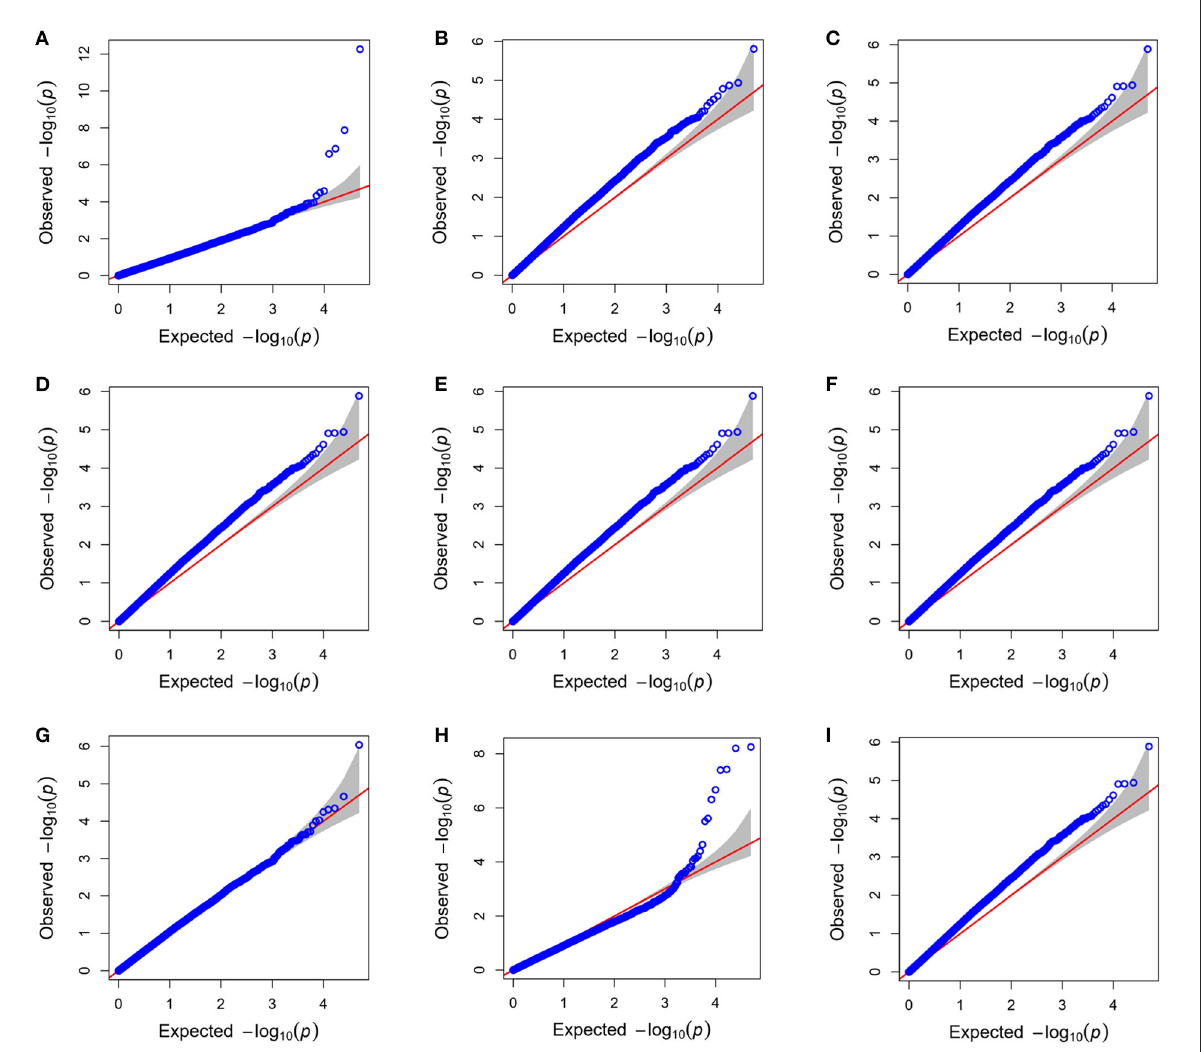
FIGURE3 The Q–Q plot for litter size at birth (LSB) fitting Bayesian-information and Linkage-disequilibrium iteratively nested keyway (BLINK) (A) ; general linear model (GLM) (B) ; mixed linear model (MLM) and multi locus mixed model (MLMM) (C) ; compressed mixed linear model (CMLM) (D) ; enriched compressed mixed linear model (ECMLM) (E) , factored spectrally transformed linear mixed model (Fast-LMM) (F) ; settlement of MLM under progressively exclusive relationship (SUPER) (G) ; fixed and random model circulating probability unification (FarmCPU) (H) ; and efficient mixed-model association (EMMA) and efficient mixed model association eXpedited (EMMAX) (I) GWAS